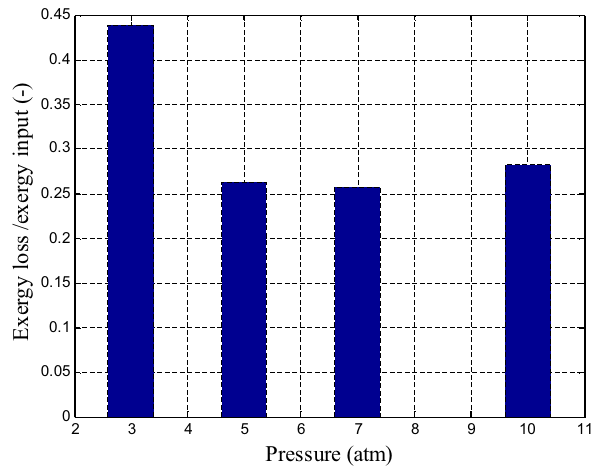
Figure 3: Exergy destruction of the CO 2 capture process using DES at selected pressure